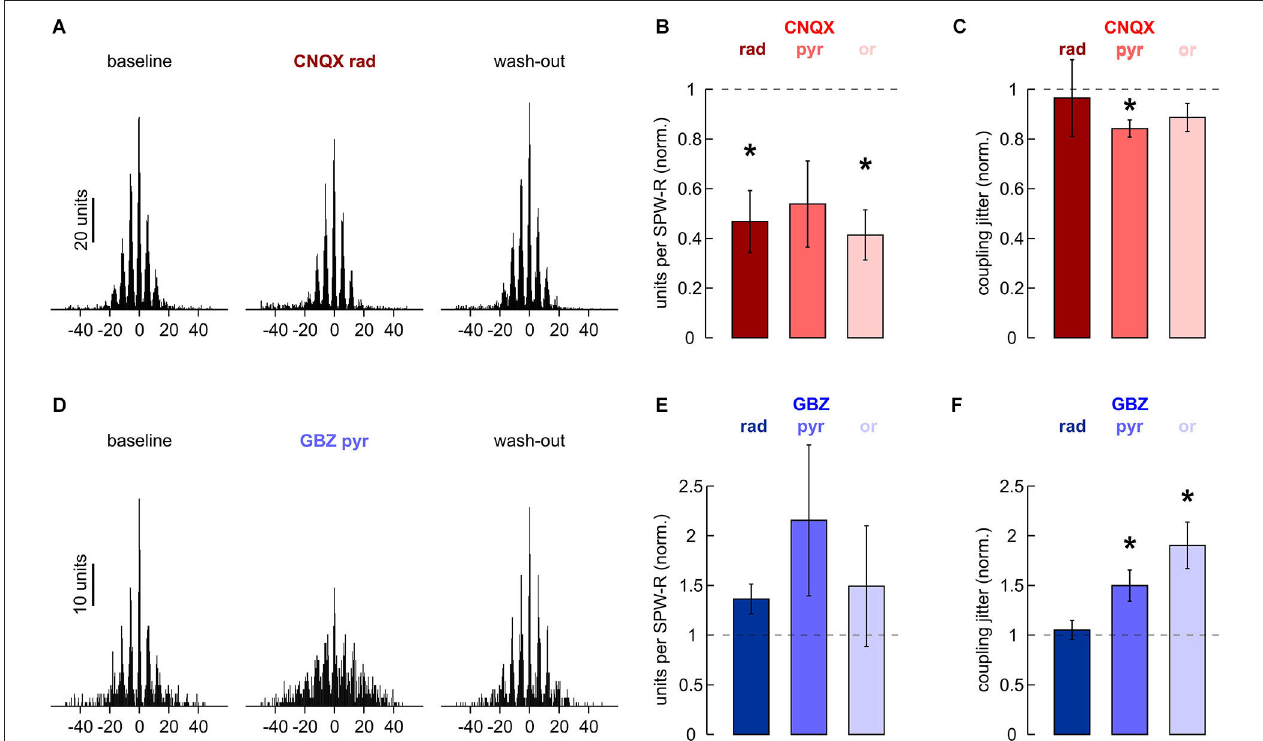
(middle) s. pyramidale ( n = 5 slices; P < 0.05) and (right) s. oriens ( n = 7 slices; P > 0.1). (D) Cross-correlation histogram of n = 291 units and n = 680 ripple troughs in s. pyramidale. (Left) baseline, (middle) after 40 min of local wash-in, (right) after 60 min wash-out. (E) Normalized MUA frequency in s. pyramidale during SPW-R after local application of gabazine to (left) s. radiatum ( n = 7 slices; P > 0.1), (middle) s. pyramidale ( n = 6 slices; P > 0.05) and (right) s. oriens ( n = 6 slices; P > 0.1). (F) Normalized coupling jitter of MUA to ripples in s. pyramidale after local application of gabazine to (left) s. radiatum ( n = 7 slices; P > 0.1), (middle) s. pyramidale ( n = 6 slices; P < 0.05) and (right) s. oriens ( n = 6 slices; P <